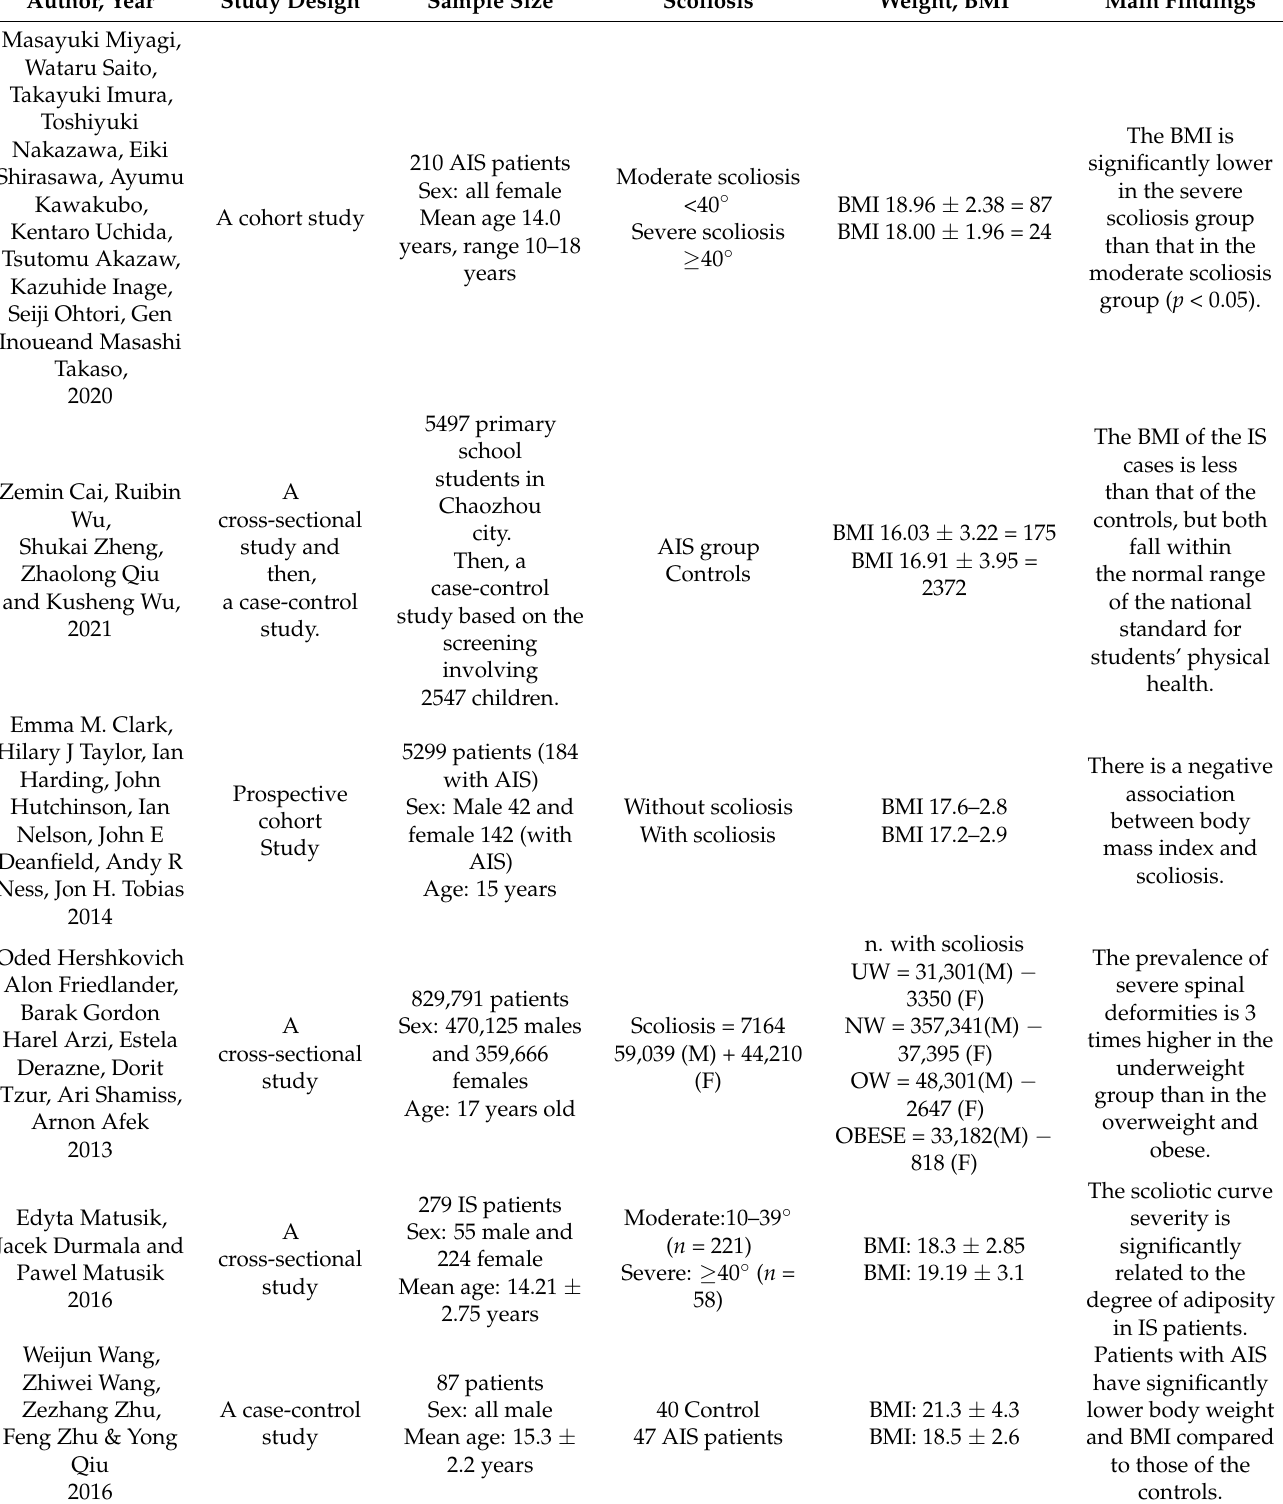
The prevalence of severe spinal deformities is 3 times higher in the underweight group than in the overweight and obese. The scoliotic curve severity is significantly related to the degree of adiposity in IS